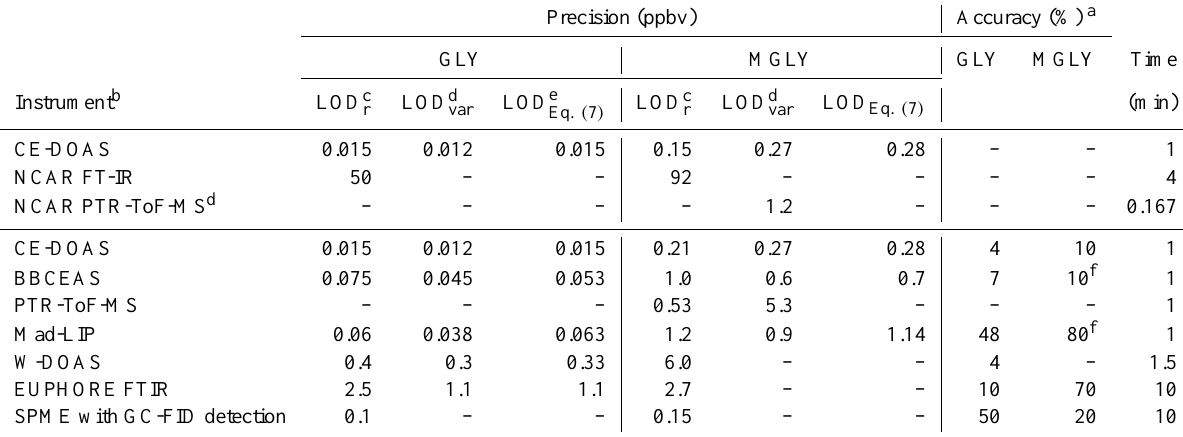
SPME with GC-FID detection 0.1 a Accuracy evaluated as the 95% CI of the fitted slopes in correlation plots versus CE-DOAS (Sect. 4.2) for experiments where signal-to-noise was at least 10; accuracy of CE-DOAS is estimated in the Supplement; b abbreviations given in the text; c operator Reported Detection Limits 3 σ ; d LOD based on measured variability at constant signal (LOD = 3 σ ppbv, see Sect. 4.2); width of Histograms in Figs. 9 and 10 for EUPHORE experiments, and as the LOD in the instruments for other background data for NCAR experiments; e LOD calculated according to Eq. (7), where |background| is equated to the offset from Figs. 9 and 10; f omits E6 due to the lack of variability in the